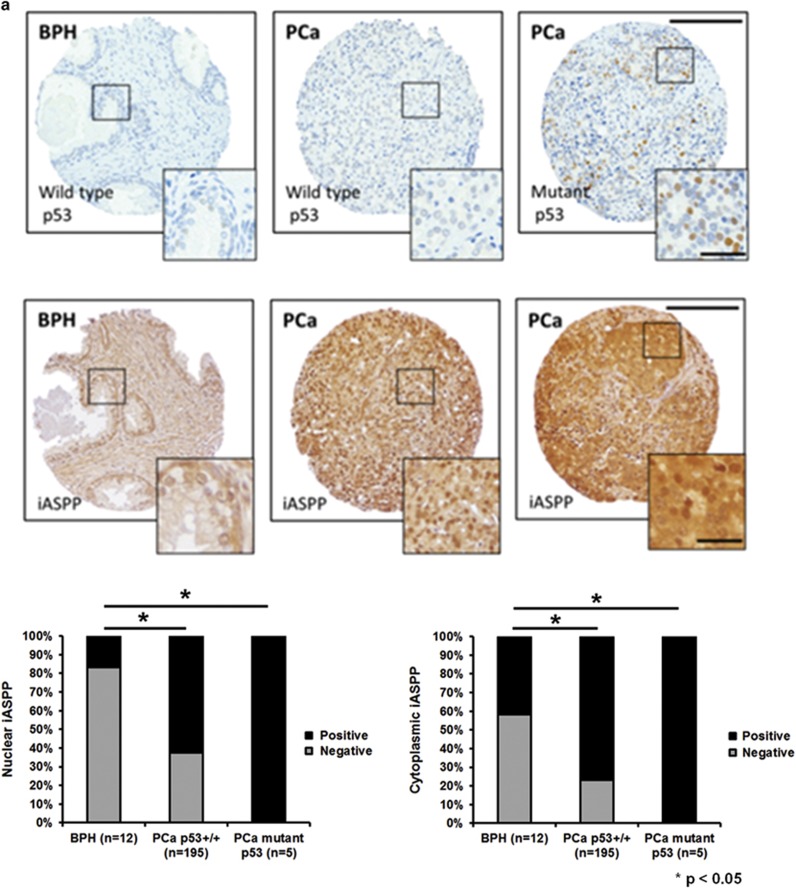
Nuclear iASPP expression was increased in prostate cancer samples with a high level of TP53 expression. (a) iASPP expression in human prostate cancer samples was greater in both wild-type p53 (<30% nuclei expressing TP53) and mutant p53 (>30% nuclei expressing TP53) samples compared with benign prostate epithelium (P<0.05). Although the number of mutant p53 prostate cancer samples was small (n=5) compared with the number of wild-type p53 samples (n=195) we observed that the nuclear iASPP expression was higher in mutant p53 samples compared with wild-type p53 samples. (b) TP53 and iASPP expression in cells within the leading edge of locally invading pT3a prostate cancer was compared with other areas of the sample. TP53 expression was greatest in invading prostate cancer cells within the leading edge. iASPP expression was higher in prostate cancer cells with high TP53 expression, compared with cancer cells with low TP53 expression, in capsular-invading and intra-prostatic areas of tumour. Arrow depicts direction of invasion into the prostate capsule. (c) Nuclear iASPP is co-expressed with nuclear TP53 in DU145 prostate cancer cells at the invasive margin in organotypic co-cultures. (d) Immunoprecipitation of TP53 probed with anti-iASPP and anti-TP53 antibodies demonstrated that iASPP interacts with mutant TP53